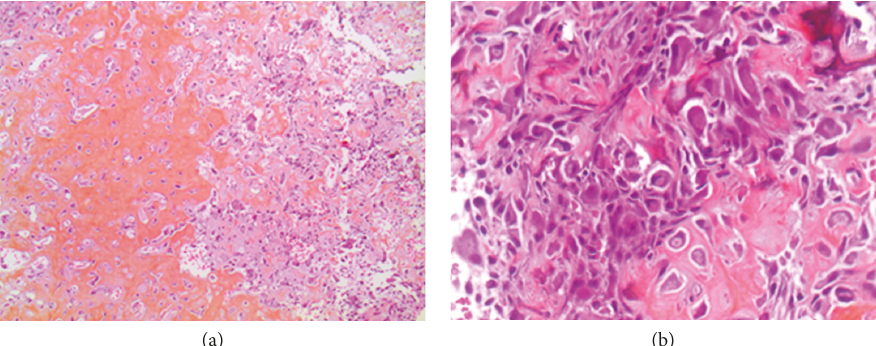
Figure 5: Histopathological examination (standard coloration). An area of hypovascular sclerotic bone surrounding the tumor is seen at low ( × 100) magni fi cation (a, left part). The intertrabecular space is fi lled with fi brovascular stroma (a, right part). The central portion of the lesion (nidus) is characterized by di ff erentiating osteoblasts engaged in the production of osteoid tissue. Absence of mitoses and necrosis. (b) × 400 magni fi